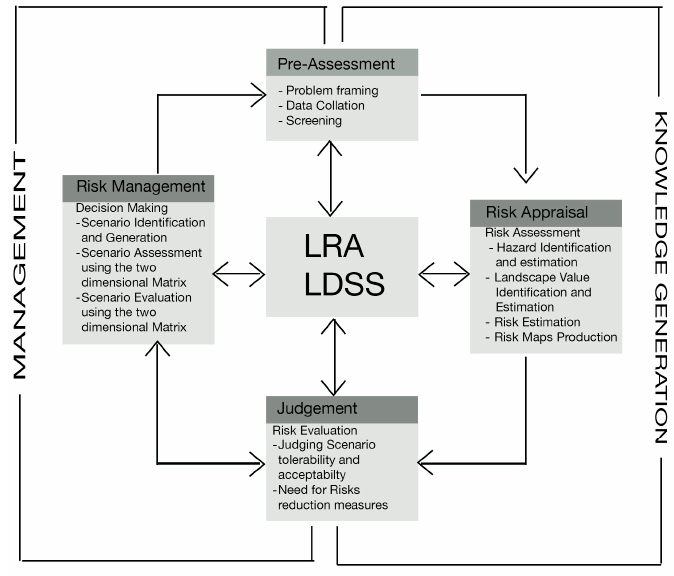
Figure 3. Landscape Risk Assessment conceptual framework.